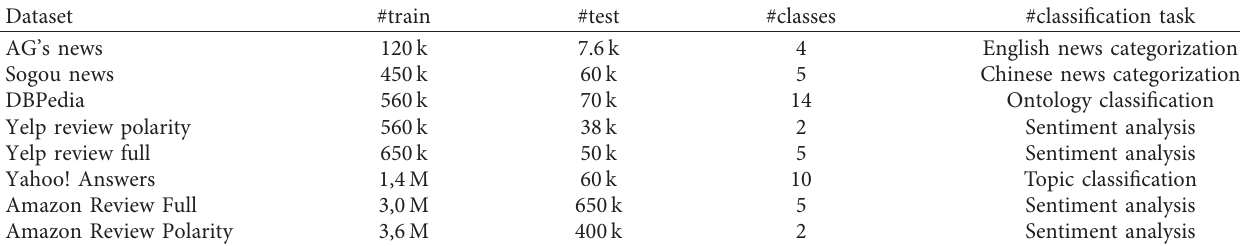
Table 1: Large-scale text classification datasets used in our experiments.